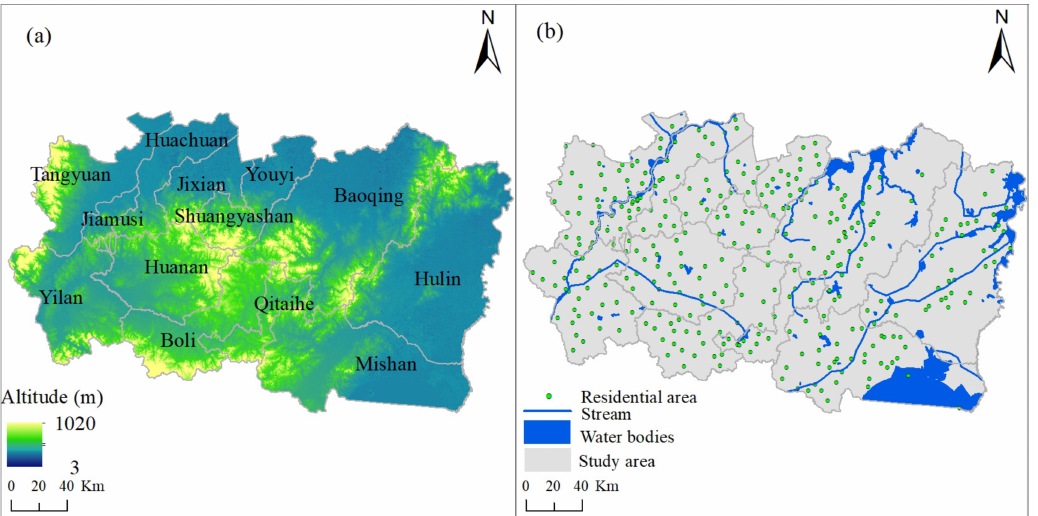
Figure 1. Spatial location map of the study area. ( a ) Base geographic information of the study area and ( b ) administrative division and elevation